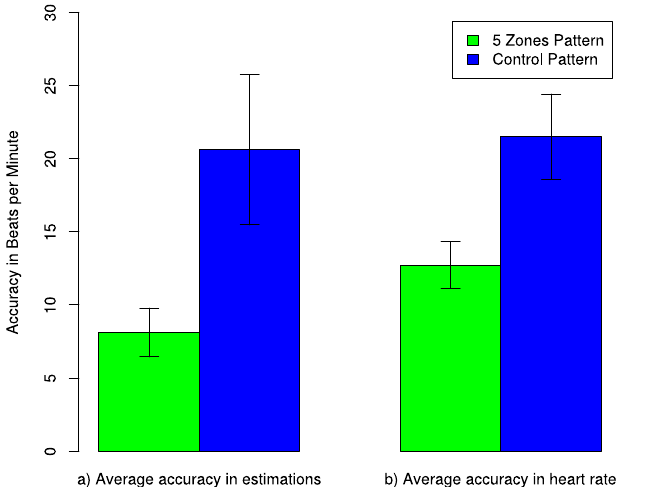
Figure 5. Ratingsforall factorsin the NASATLXincludingthe overall rating. Errorbars showthe standarderror. P values were computedusing the Wilcoxon signed rank test with continuity correctionto checkforsignifican